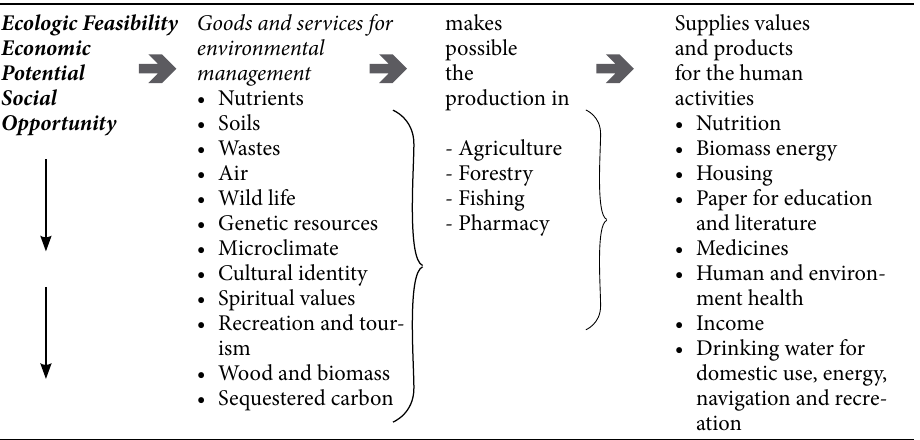
Fig. 2. Relations between consumers’ basic needs and environmental services through the prism of ecological feasibility, economic potential and social opportunity